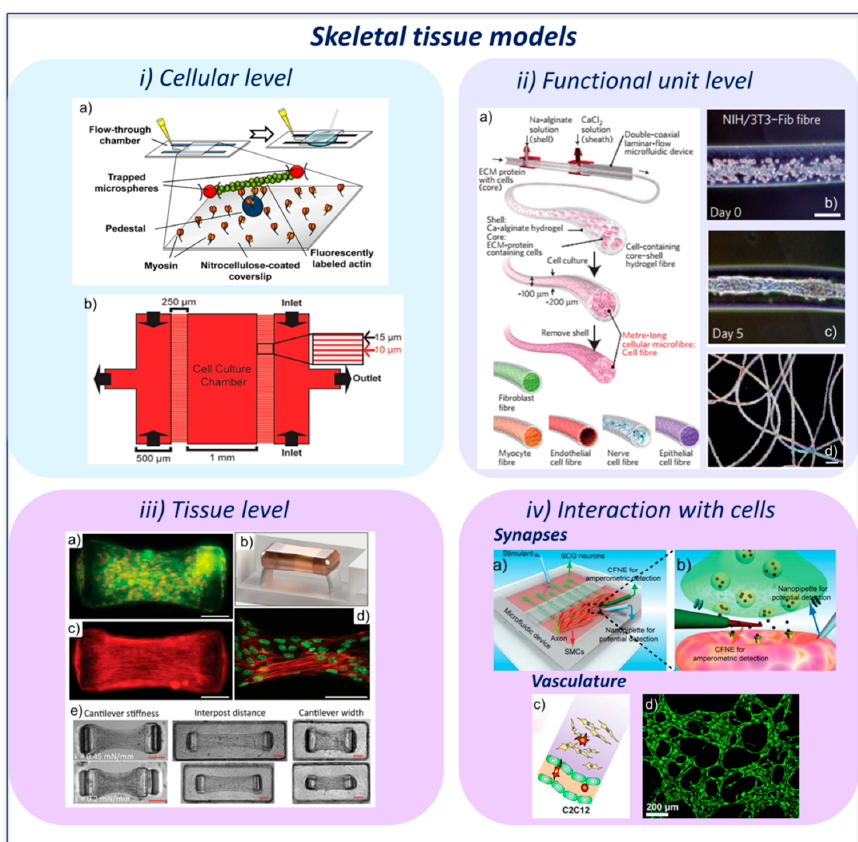
Figure 3. Microfluidic models of skeletal muscle. ( i-a ) Schematics and detail of a molecular mechanics assay chamber (left) and prototype of a microfluidic device (right) which allows to introduce chemicals without creating bulk flows compromising mechanics measurements. Reproduced by